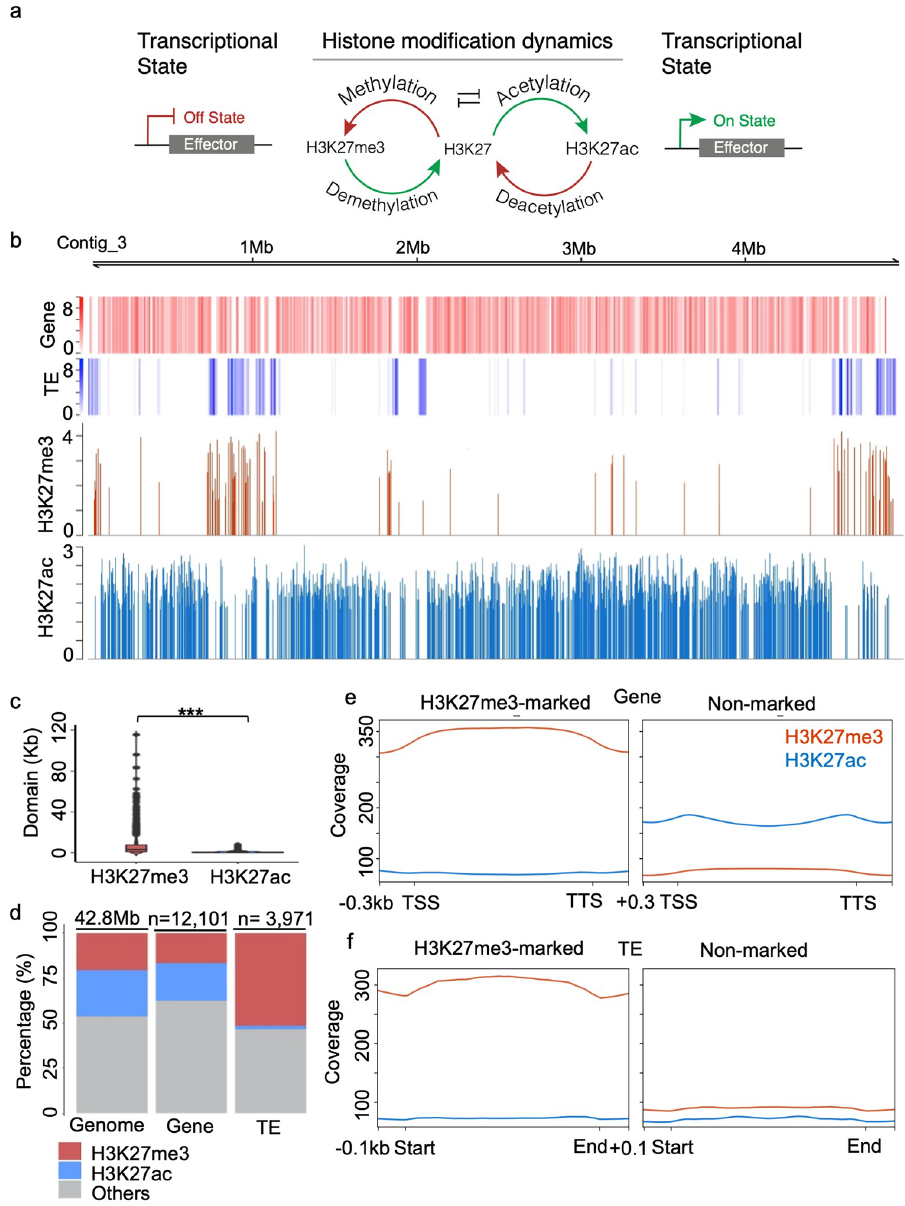
Fig 1. Methylation and acetylation at H3K27 occupy repressive and active genomic regions with distinct distribution profiles. (A) A working model for the dynamics of histone modification at H3K27 regulating fungal effector gene expression. (B) ChIP signals for H3K27me3 and H3K27ac occupy distinct genomic regions in M . oryzae Guy11 wild type growing in complete medium. (C) Violin plots illustrating genome-wide distributions of domains of H3K27me3 and H3K27ac. (D) Bar chart illustrating the percentage of genome (Geno), gene and transposable element (TE) marked by H3K27me3 and H3K27ac in wild type grown in complete medium. (E) and (F) ChIP signal profiles of H3K27me3 and H3K27ac on genes (E) and TEs (F) that marked (left) and non-marked (right) by H3K27me3.